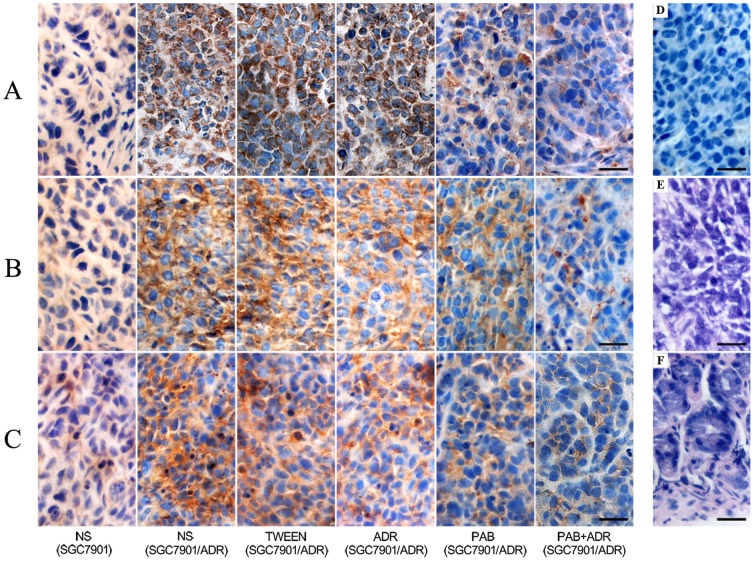
Cox-2, PKC-α, and P-gp expression levels of xenografts in different groups (×400).A: expression of Cox-2 in mice xenografts B: expression of PKC-α in mice xenografts C: expression of P-gp in mice xenografts D: negative control E: xenograft by HE F: normal gastric tissue by HE. Tissues were fixed, embedded, mounted and stained by the SP method or HE staining using standard procedures. Scale bar, 25 µm.